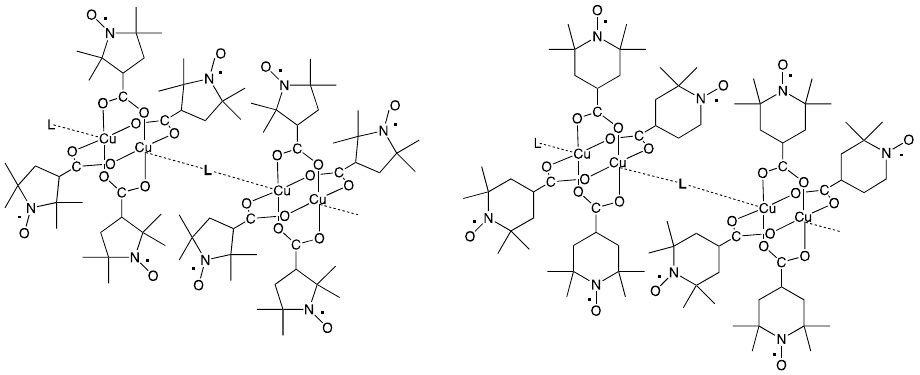
Figure 2. Chain compounds of Cu 2 (caproxy) 4 and Cu 2 (catempo) 4 with N , N’ -bidentate ligands, L.